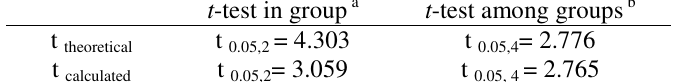
Table 4. t -Test of stepwise adsorption adsorbance of salad oil on EG t -test in group a t -test among groups